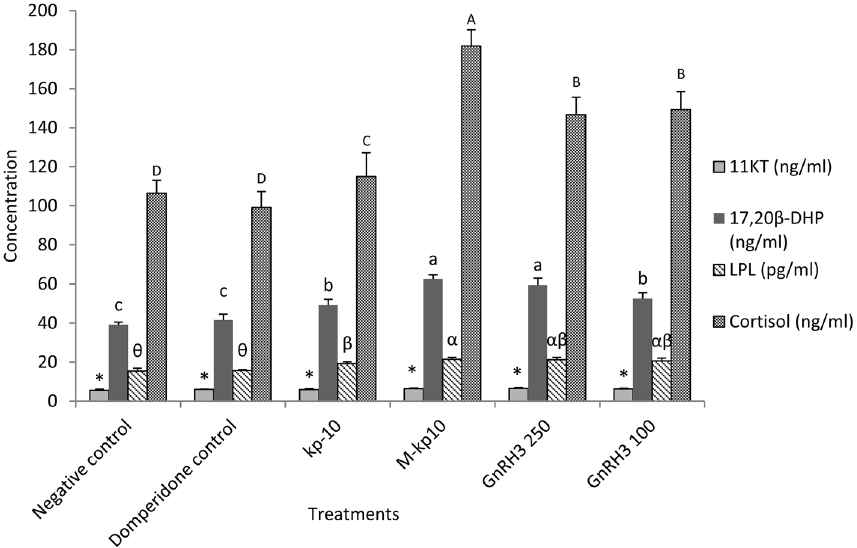
Figure 2. Variations of 17α-20β-Hydroxy-4-peregnen-3-one (DHP), 11-keto testosterone (11KT), lipoprotein lipase (LPL) and cortisol in the female goldfish treated with kp-10, M-kp10 and GnRH3, 6 h post-injection. The